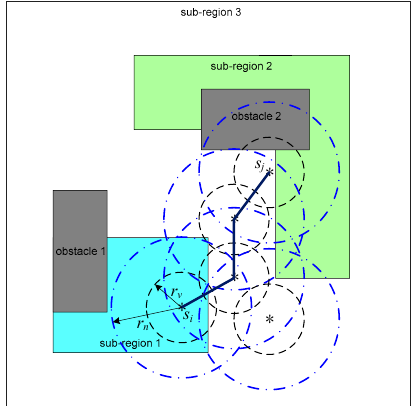
Figure 7. A path that connects the sensors s i and s j . Black circle is the sensing range of virtual sensor. Black asterisk refers to the position of the sensor. Blue circle denotes the neighboring radius of the virtual sensor.